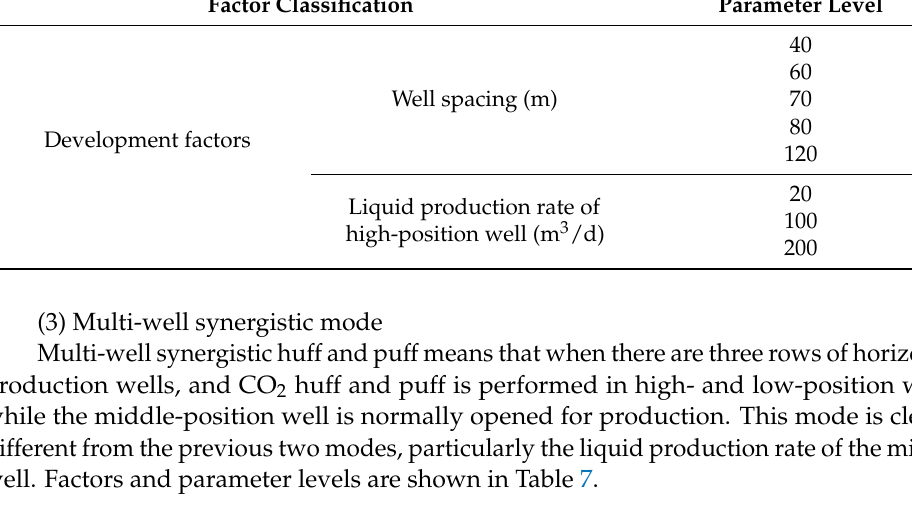
Table 7. Factors and parameter levels of multi-well synergistic